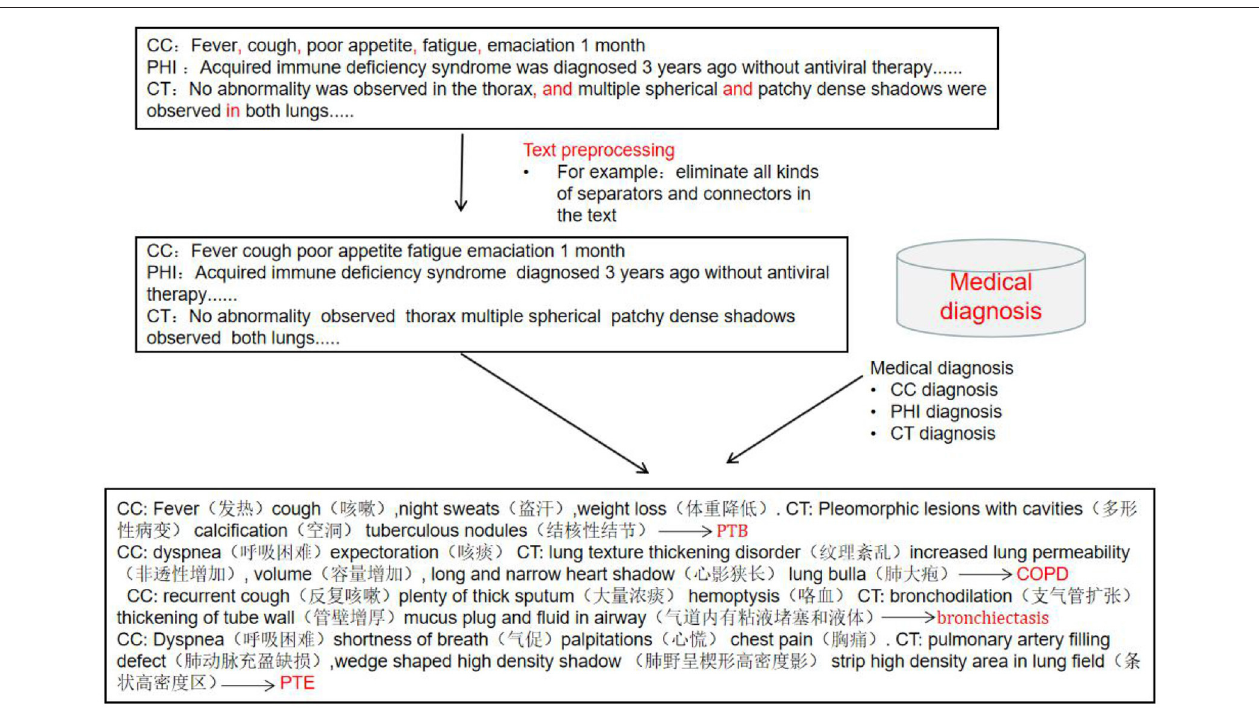
FIGURE 2 | Text pre-processing and medical diagnosis.